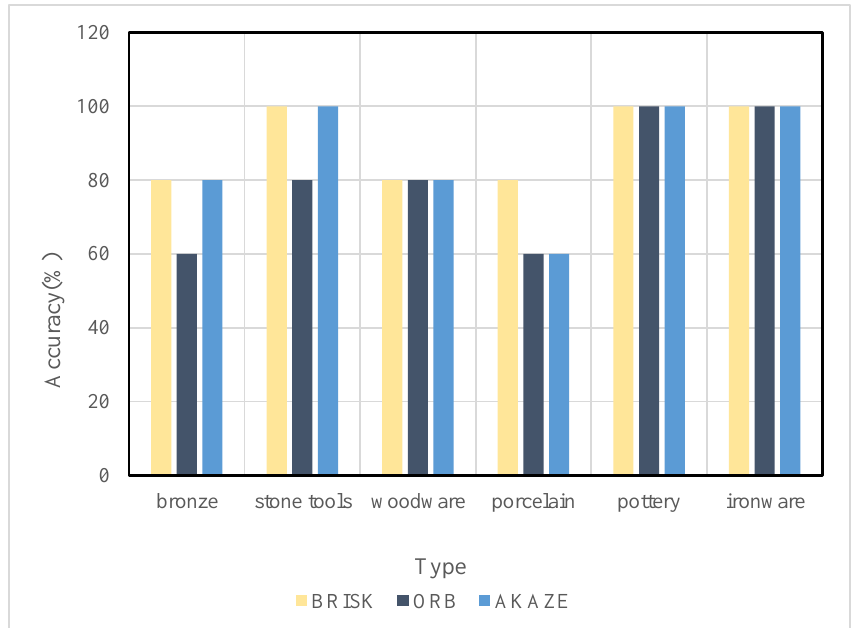
Figure 3. Comparison of the accuracy of the three algorithms.